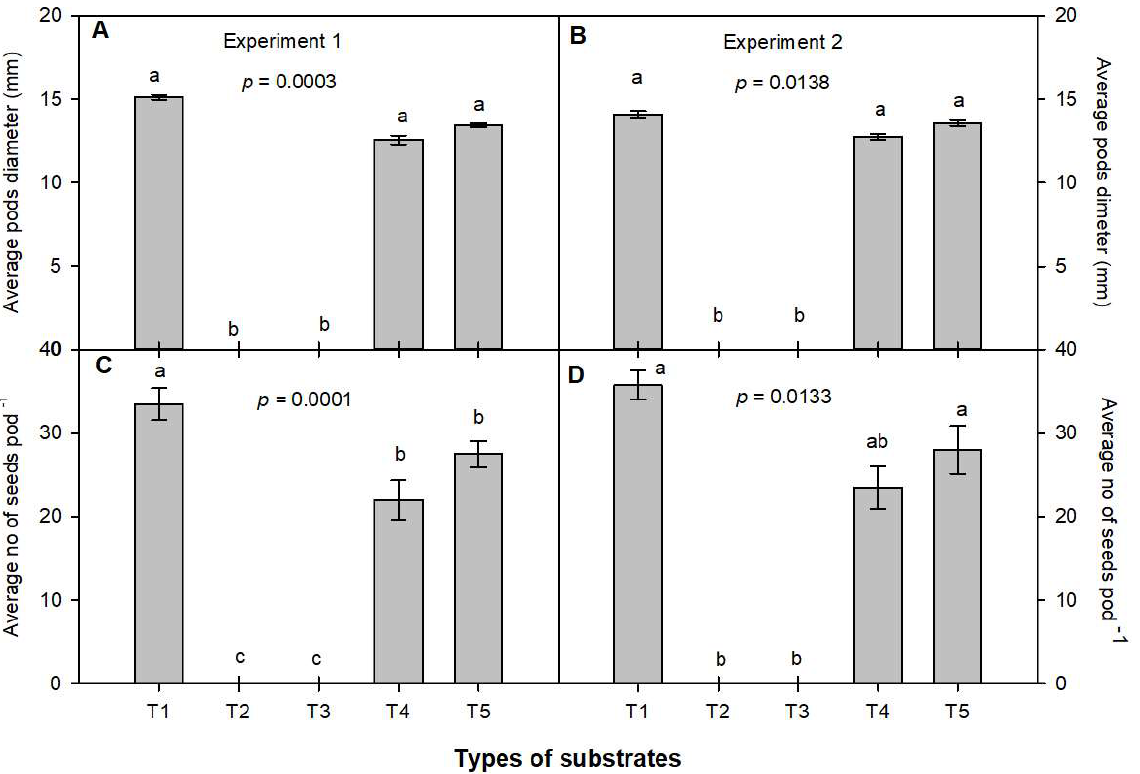
Figure 6. Effect of non-composted Bombax ceiba (Red cotton tree) sawdust mixtures on Abelmoschus esculentus L. (okra). Average diameter of pods (mm) ( A , B ) and average number of seeds pods −1 ( C , D ) in two independent experiments. All treatments (T 1 , T 2 , T 3 , T 4 , T 5 ) were the same as described in Figure 1. Different letters display significant differences between treatment mean values at the top of the vertical bars, as determined by the least significant difference test (LSD) at p < 0.05. Differences between treatments were very significant, as evidenced by the p = 0.0000. The error bars show the standard error ( n = 4). There was no pod development in T 2 and T 3 before harvest.